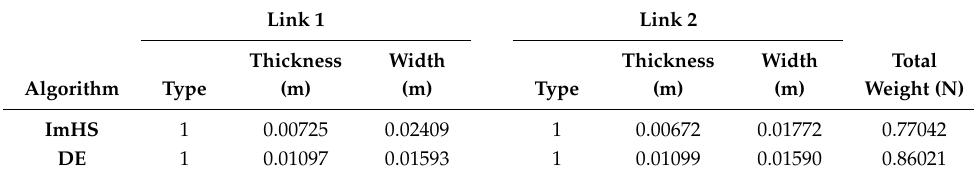
Table 5. Best solutions of ImHS and